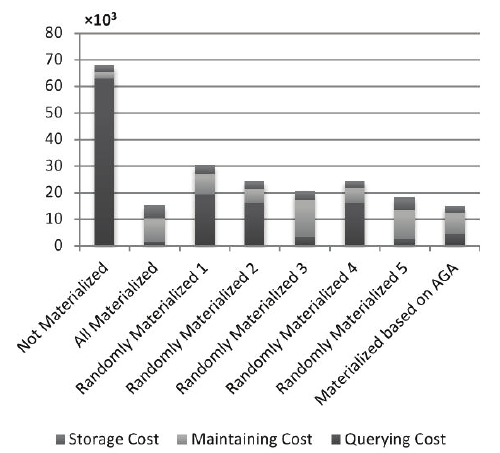
Fig. 8. The cost of different materialization methods with Apache Hive using partial lattice